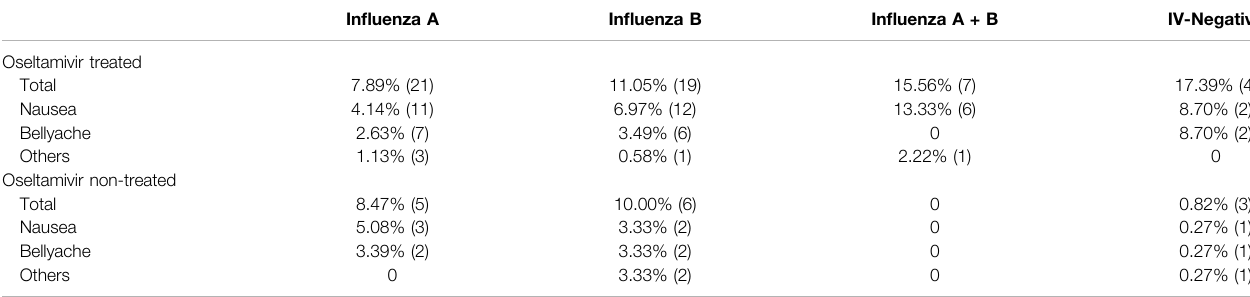
TABLE 5 | Adverse effects after